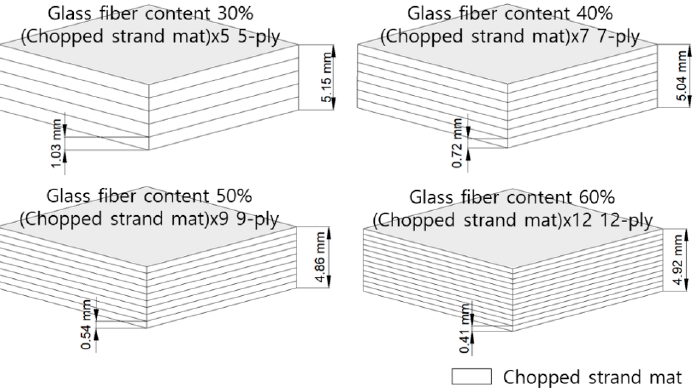
Figure 3. Designs of single-material specimens produced using chopped strand mat. Table 1. Design details of single-material specimens.